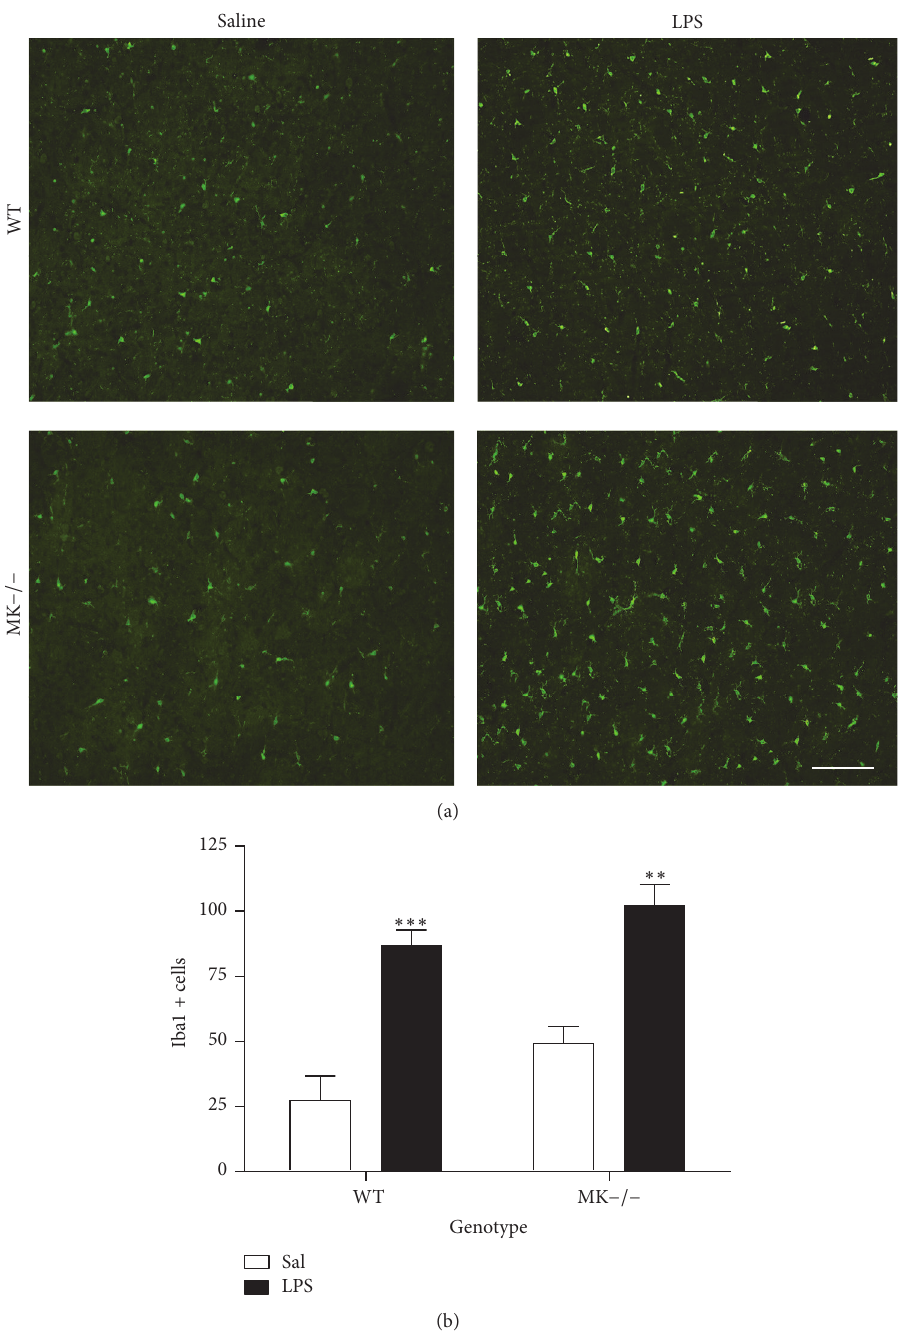
Figure 5: LPS-induced microgliosis in the striatum of WT and MK − / − mice. (a) Photomicrographs are from Iba-1-immunostained striatal sections of saline- (Sal-) treated or 0.5 mg/kg lipopolysaccharide- (LPS-) treated animals. (b) The graph represents quantification of data (mean ± SEM) obtained from the counts of Iba-1-positive cells in standardized areas of the striatum. Significant effects of the genotype ( F (1,12) = 5.17, 𝑃 = 0.04 ) and treatment ( F (1,12) = 47.41, 𝑃 < 0.0001 ) were found. ∗∗ 𝑃 < 0.01 and ∗∗∗ 𝑃 < 0.001 versus Sal. Scale bar = 200 𝜇